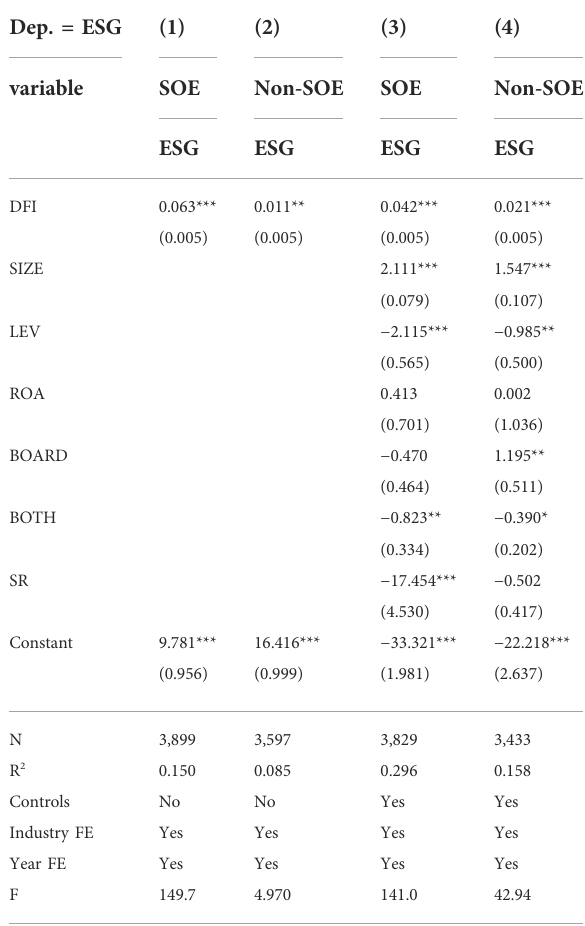
TABLE 4 Test of the effect of fi nancial constraint. TABLE 5 Test of the impact of